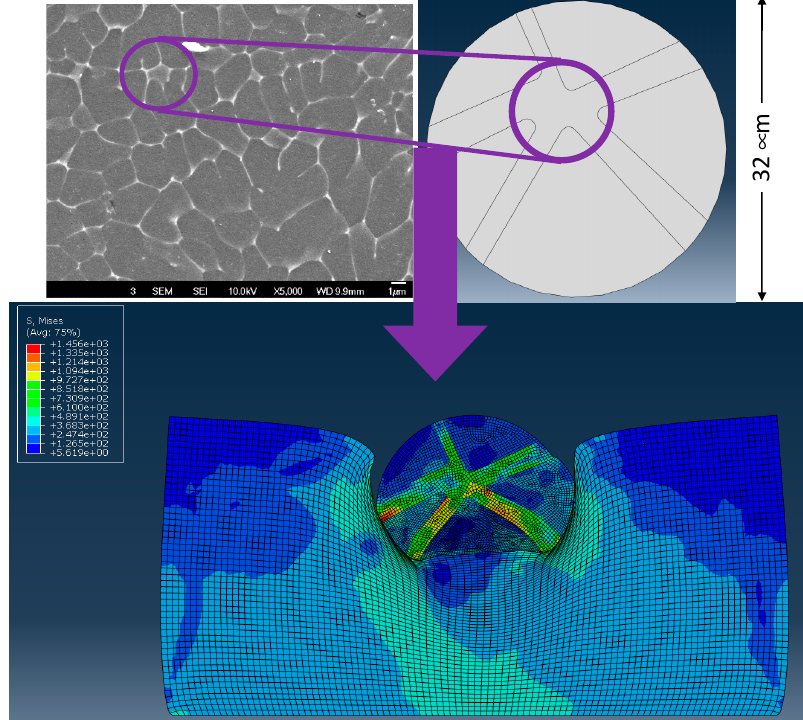
Figure 13. A FEA single particle impact using hard intermetallic network along boundaries.